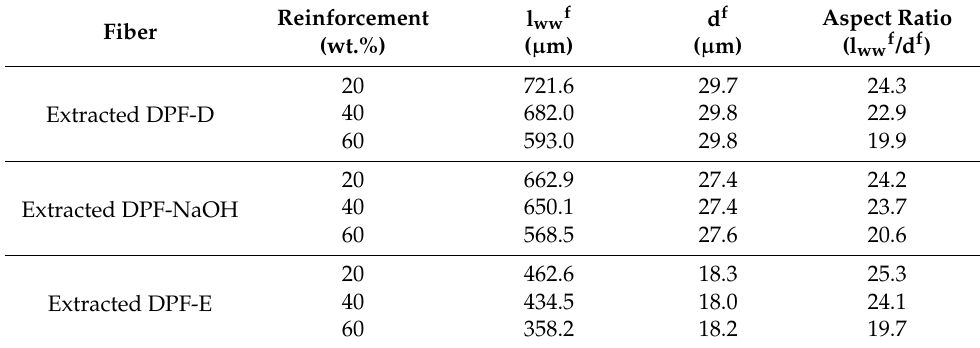
Table 3. Mean fiber length and diameter of extracted date palm